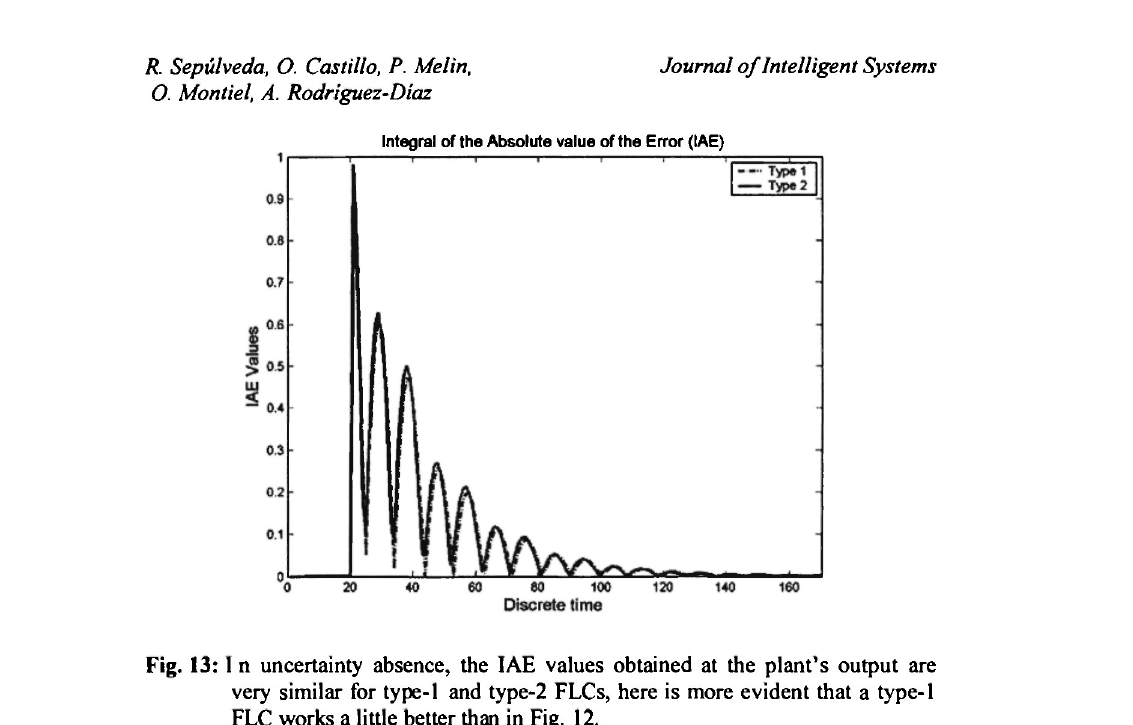
Fig. 13:1 η uncertainty absence, the IAE values obtained at the plant's output are very similar for type-1 and type-2 FLCs, here is more evident that a type-1 FLC works a little better than in Fig. 12.